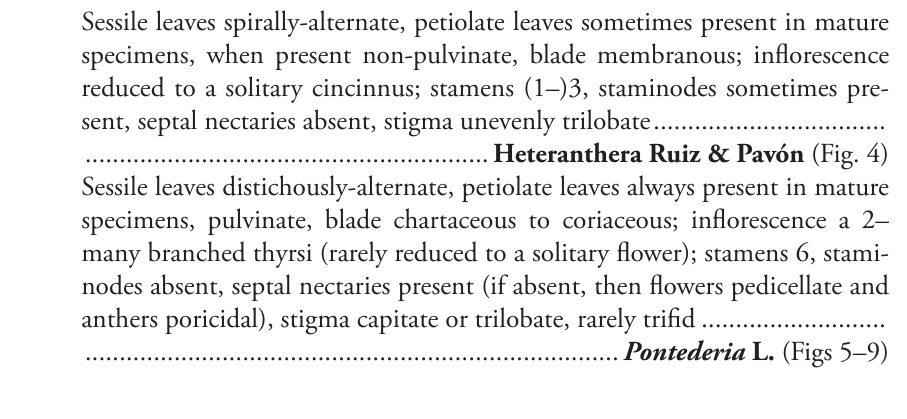
Type species (designated by Lowden 1973). Pontederia cordata L. Description. Herbs perennial or annual, aquatic to amphibious, erect-emergent, procumbent-emergent or free-floating. Roots thin, fibrous or spongy. Rhizome short and generally inconspicuous. Stems trailing to erect, delicate to spongy, branching at the base, rarely branching at the upper half, rooting at the basal nodes or along the whole stem; internodes reduced to elongate, producing stolons or not. Sessile leaves distichously-alternate, congested at the apex of the stem, submerged, deciduous or persistent in mature plants, blades linear to linear-obovate, membranous, rarely charta- ceous. Petiolate leaves distichously or spirally-alternate, congested at the apex of the stem or evenly distributed along the stem, floating or emergent, ligule truncate or with a flabellate projection; petioles conspicuous, rarely indistinct, inflated or not; blades elliptic to lanceolate or ovate to cordate to reniform or obovate to rounded, charta- ceous to coriaceous. Synflorescence composed by a solitary main florescence subtended by a vegetative, petiolate leaf. Main florescences (inflorescences) axillary or apparently terminal, consisting of a pedunculate, many-branched thyrse, rarely a reduced thyrse; inflorescence leaf with or without an inflated leaf-sheath; basal bract flat or tubular; cincinnus’ bract absent; cincinni (1–3–)4 – many per thyrse, alternate or fascicle-like, 1 – many-flowered, sessile or pedunculate, internodes contracted, rarely elongate; brac- teoles absent, rarely present. Flowers bisexual, sessile or pedicellate, chasmogamous, pseudo-homostylous or tristylous, enantiostylous, zygomorphic, perianth connate usually forming a tube (hypanthium), rarely only basally fused, campanulate or in- fundibuliform or hypocrateriform, white to light pink to pink to mauve to pale lilac to lilac to bluish-lilac to purple, lobes 6 (3 outer and 3 inner), elliptic to oblong to obovate, 3 superior and 3 inferior, rarely 5 superior and 1 inferior, the central superior lobe generally with a nectar guide, consisting of 1–2 yellow to green spots, generally surrounded by a dark purple to bluish-purple, rarely white blur, spirally-coiling